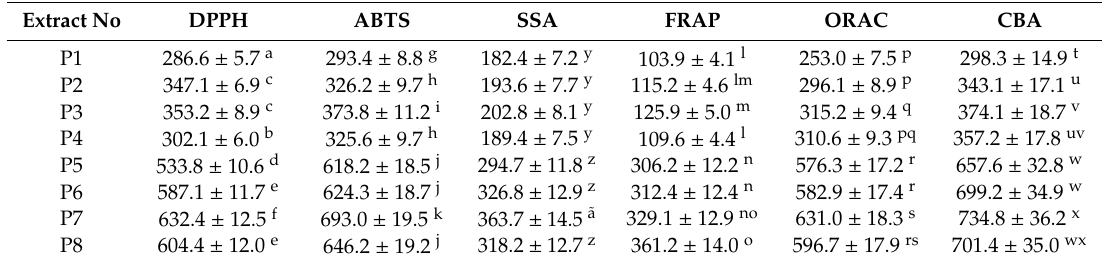
Table 5. Antioxidant activity of G. bifida extracts in six assays a , in µ M trolox-eq. / g of dry weight ± S.D. Extract No